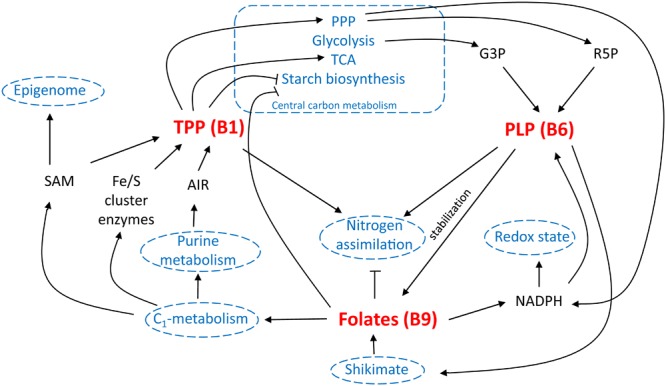
B-vitamin interplay in planta. Different interactions of vitamin B1 [via thiamin pyrophosphate (TPP) functioning], B6 [via pyridoxal phosphate (PLP) functioning] and B9 (folates) are schematically displayed. Well-established links are indicated in black, potential interactions are indicated in blue. TCA, tricarboxylic acid cycle; PPP, pentose phosphate pathway; G3P, glyceraldehyde 3-phosphate; R5P, ribose 5′-phosphate; SAM, S-adenosylmethionine; AIR, 5-aminoimidazole ribonucleotide; NADPH, nicotinamide adenine dinucleotide phosphate.